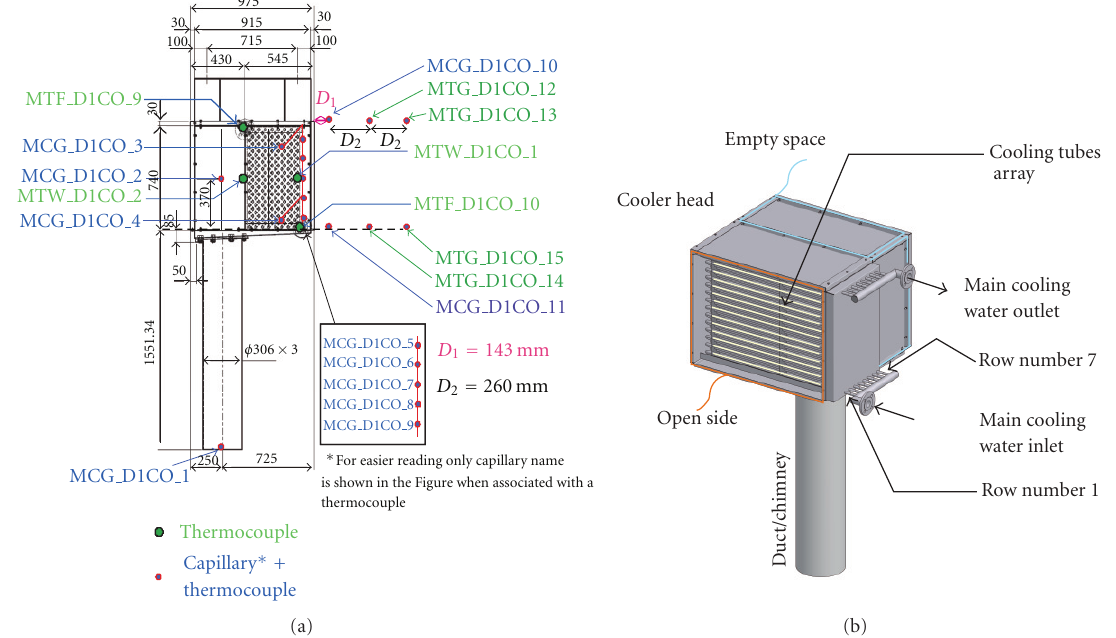
Figure 2: Sensor locations for mass spectrometer sampling lines and TCs in the cooler.